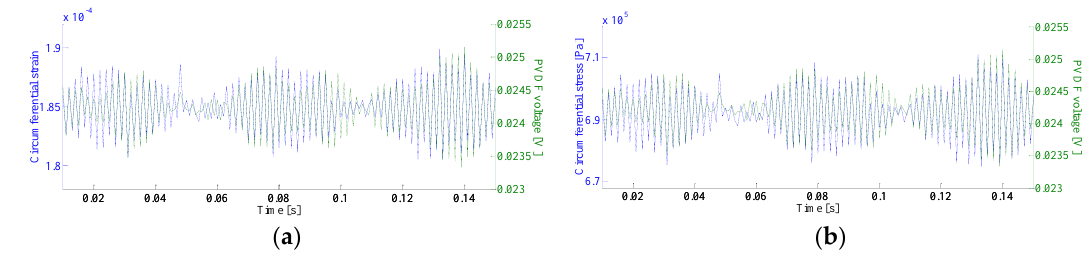
Figure 8. Comparison curves of ( a ) circumferential strain and PVDF voltage; ( b ) circumferential stress and PVDF voltage. Table 2. Correlation coefficient.